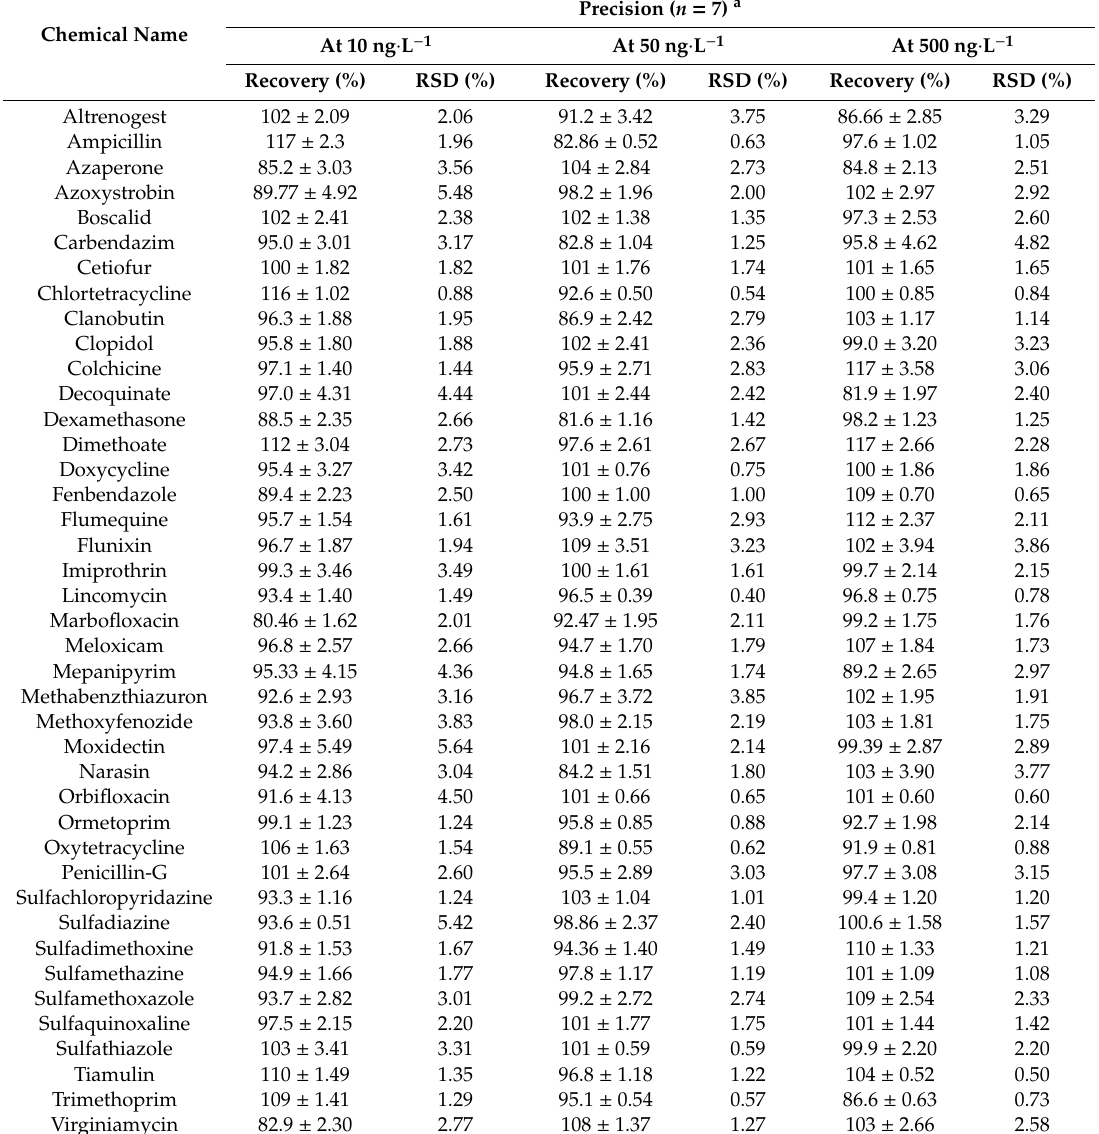
Table 5. Precisions including recovery and relative standard deviation (RSD) of the developed method with on-line SPE for target